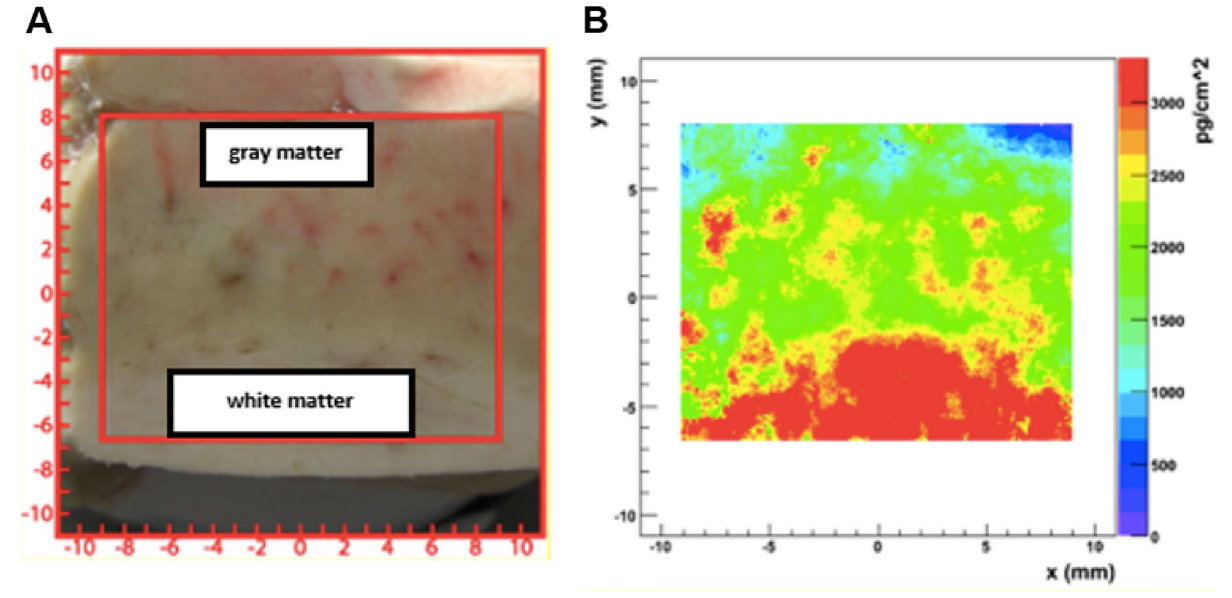
Figure 10. NIK Measurement result: ( A ) cryotome sample* ( B ) Lithium area density λ. For the position reconstruction, including the particle straggling a typical resolution of σ x,y ≈ 0.4 mm was achieved. *Comparative sample: frontal lobe (lithium